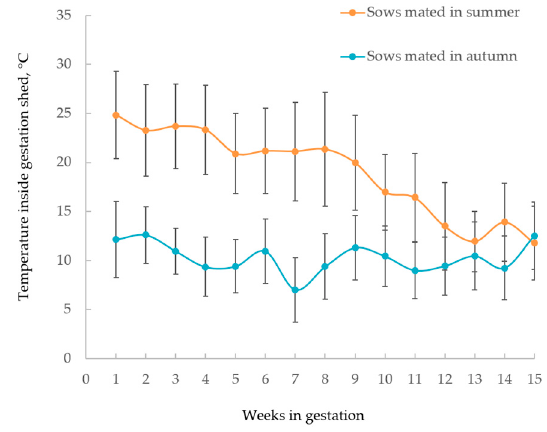
Figure 2. Temperature record of gestation shed (mean ± standard deviation).